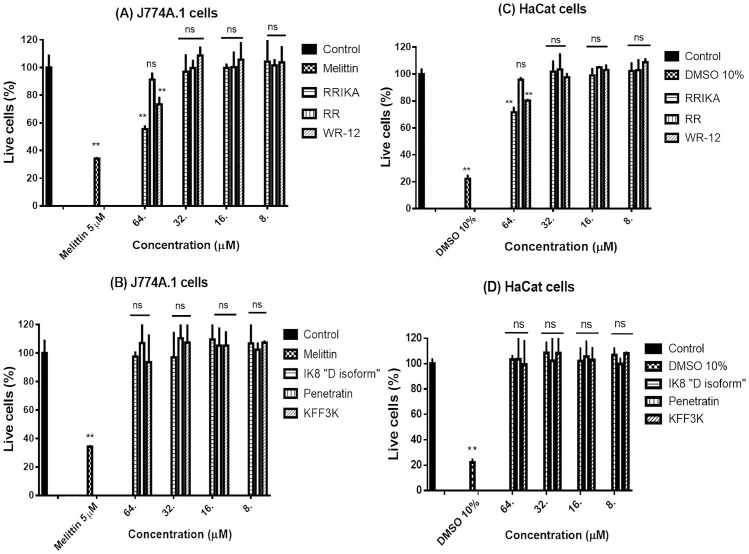
Cytotoxicity assay showing the percent mean absorbance at 490 nm after incubating macrophage cell line (J774A.1) (A &B) and human keratinocyte (HaCat) (C&D) with peptides at different concentrations.Melittin and DMSO served as positive control in J774A.1and HaCat cells, respectively. Water (peptide diluent) served as negative control. Cell viability was measured by MTS assay. Results are expressed as means from three measurements ± standard deviation. Data were analyzed using one-way ANOVA, with post hoc Tukey's multiple comparisons test to determine statistical significance. Two asterisks (**) means statistical different (p<0.01) from the negative control while (ns) means there was no statistical significance from the negative control.